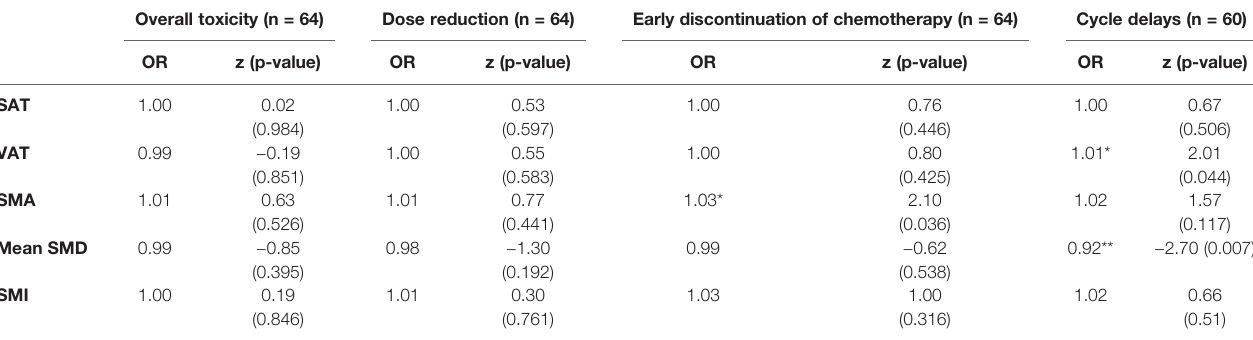
TABLE 2 | Univariate logistic regressions for the association of body composition values, toxicity, dose reduction, early discontinuation of chemotherapy, and cycle delays.